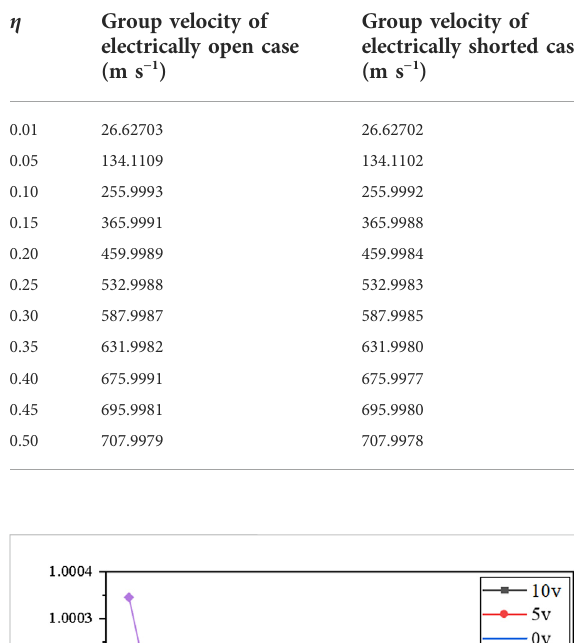
TABLE 3 Group velocity of different electrical conditions at the free edge calculated by TVPT.